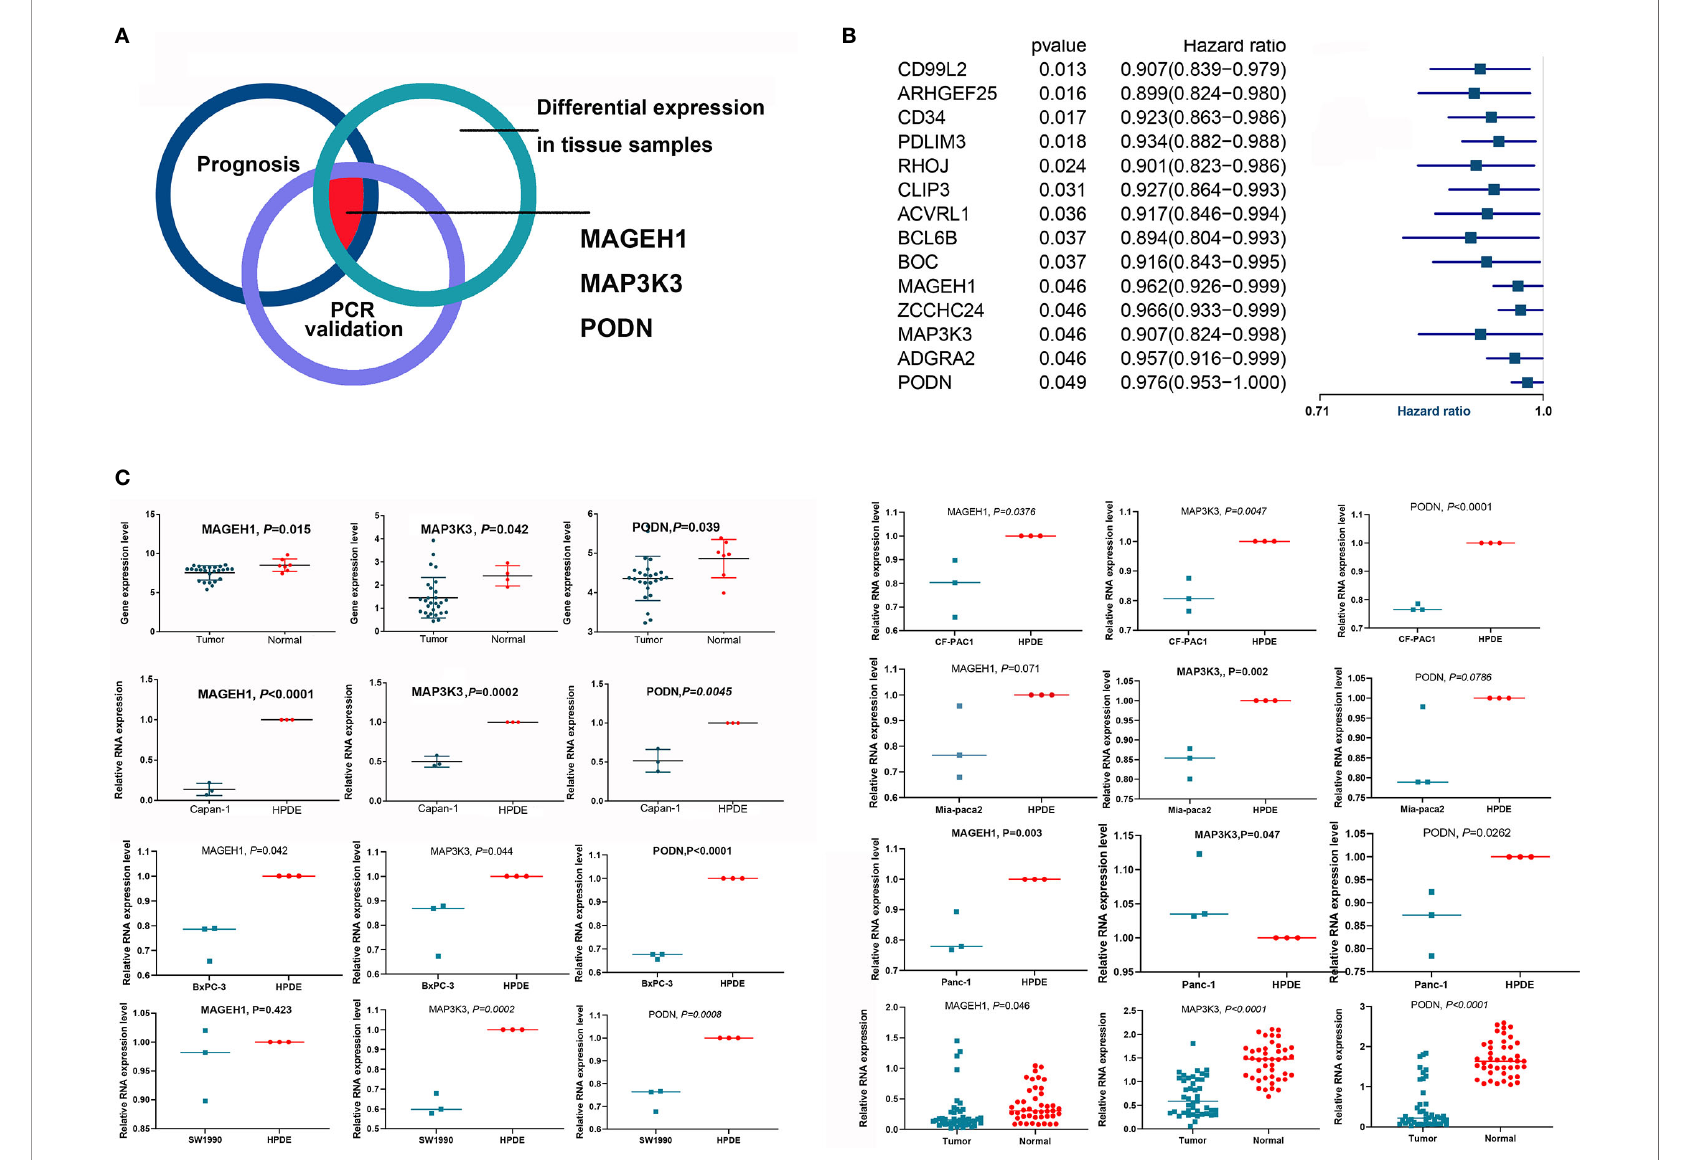
FIGURE 6 | Validation of the differential expression of key OS-related genes. (A) The diagram shows that MAGEH1, MAP3K3 and PODN were validated in silico and by qRT-PCR. (B) Fourteen key genes were associated with the OS of patients with PDAC. (C) MAGEH1, MAP3K3 and PODN were downregulated in tumor tissues and cell